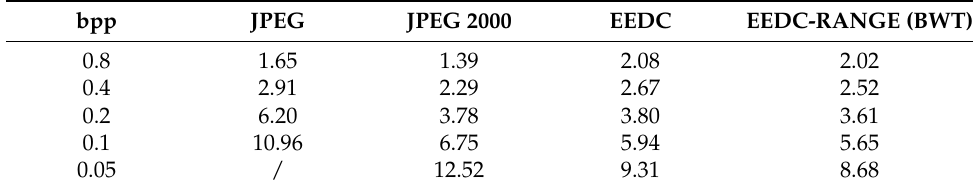
Table 7. AAE values comparison.